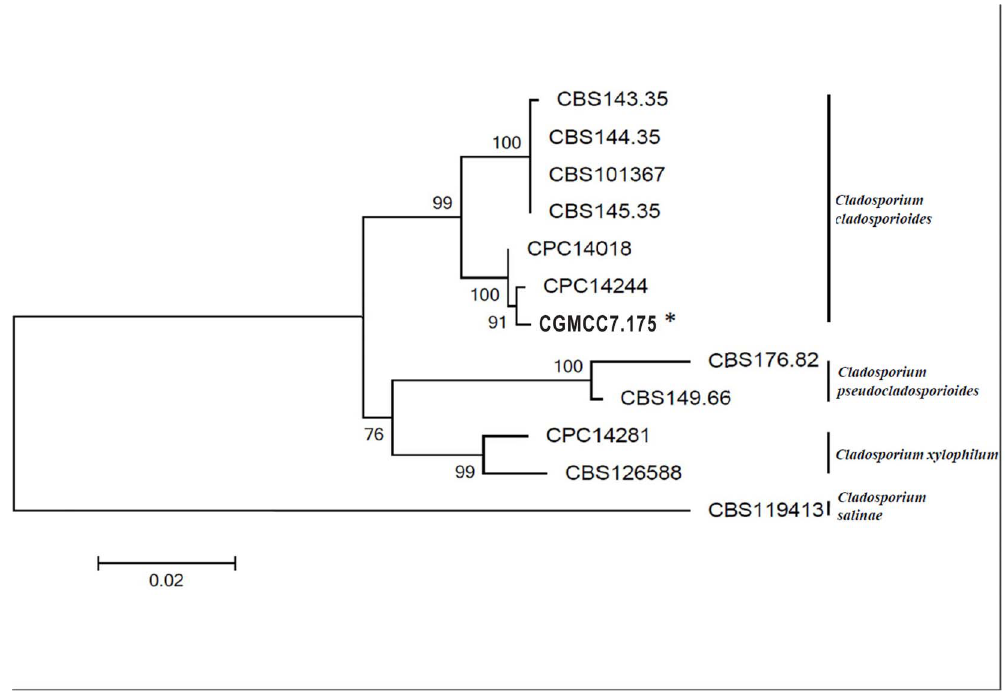
Figure 6. A neighbor-joining tree constructed using the sequences of ITS,EF and ACT to determine the phylogenetic relationship of the hyperparasitic fungal strain CGMCC 7.175 (bold and marked with *) isolated from uredinia of Pst with other accessions of Cladosporium spp. in GenBank. The values at braches are percentages from 1,000 bootstrap replications.